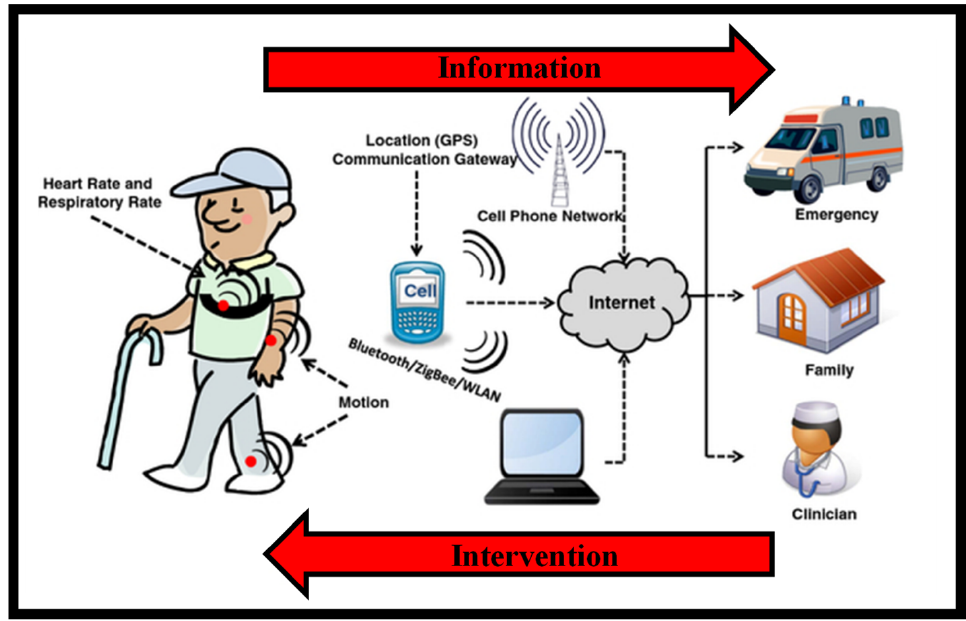
Figure 2. Design of a remote health observing arrangement established on wearables. Health-related data are collected via body-worn wireless devices and transferred to the caregiver via a data gateway, for instance, a mobile phone. Caregivers can utilize this data to execute interventions as required [19].